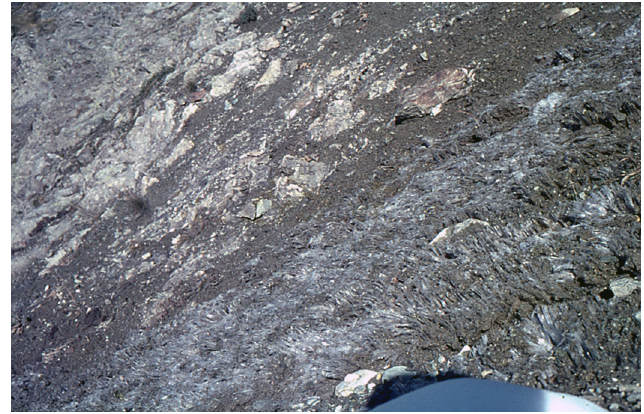
Fig. 13: Needle ice on the SW-exposed slope at 2,345 m above Pontresina village where historical Bergamask sheep and re-introduced ibex destroyed the plant cover. Needle ice (length 4 - 5 cm) formed on exposed mineral soil after several days of rain followed by night temperatures of -6 °C. When the melting ice needles fall over, uplifted loose soil particles Fig. 11: Swiss stone pine ( Pinus cembra , three meters high) will be translocated downslope. Water-saturation of loose damaged by ibex on Munt da la Bês-cha above Pontresina material causes solifluction or mudflow. Photo taken by the village at 2340 m. Photo taken by the author, 17 September author, 6 October 1967, 1967.